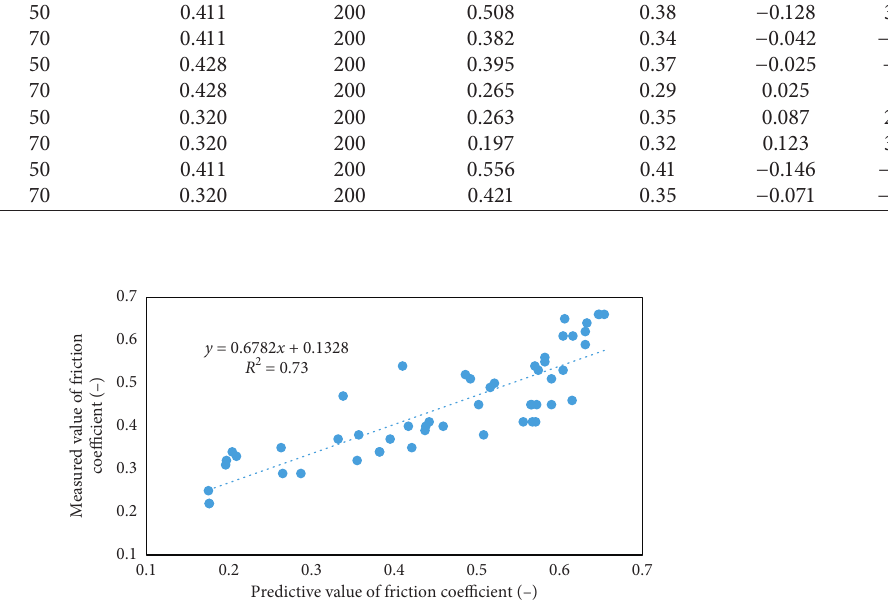
Figure 7: Correlation between the predictive value and the measured value of friction